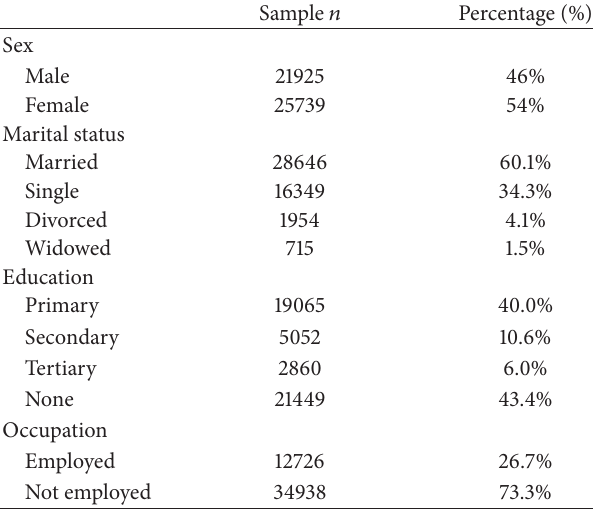
Table 1: Sociodemographic characteristics of the patients utilizing mental and neurologic services in northeast between 2001 and 2010.